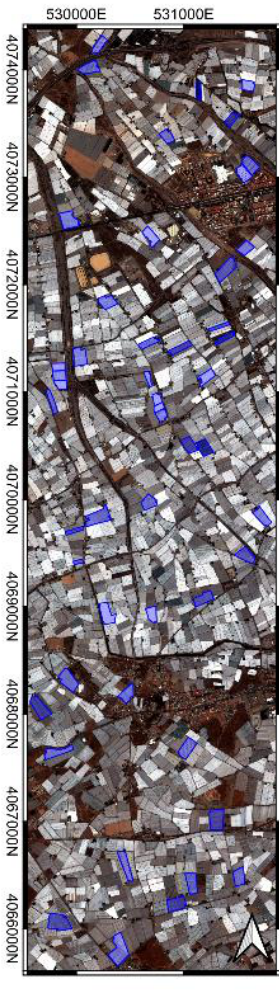
Figure 3 . Reference PCG in blue over WV3 July